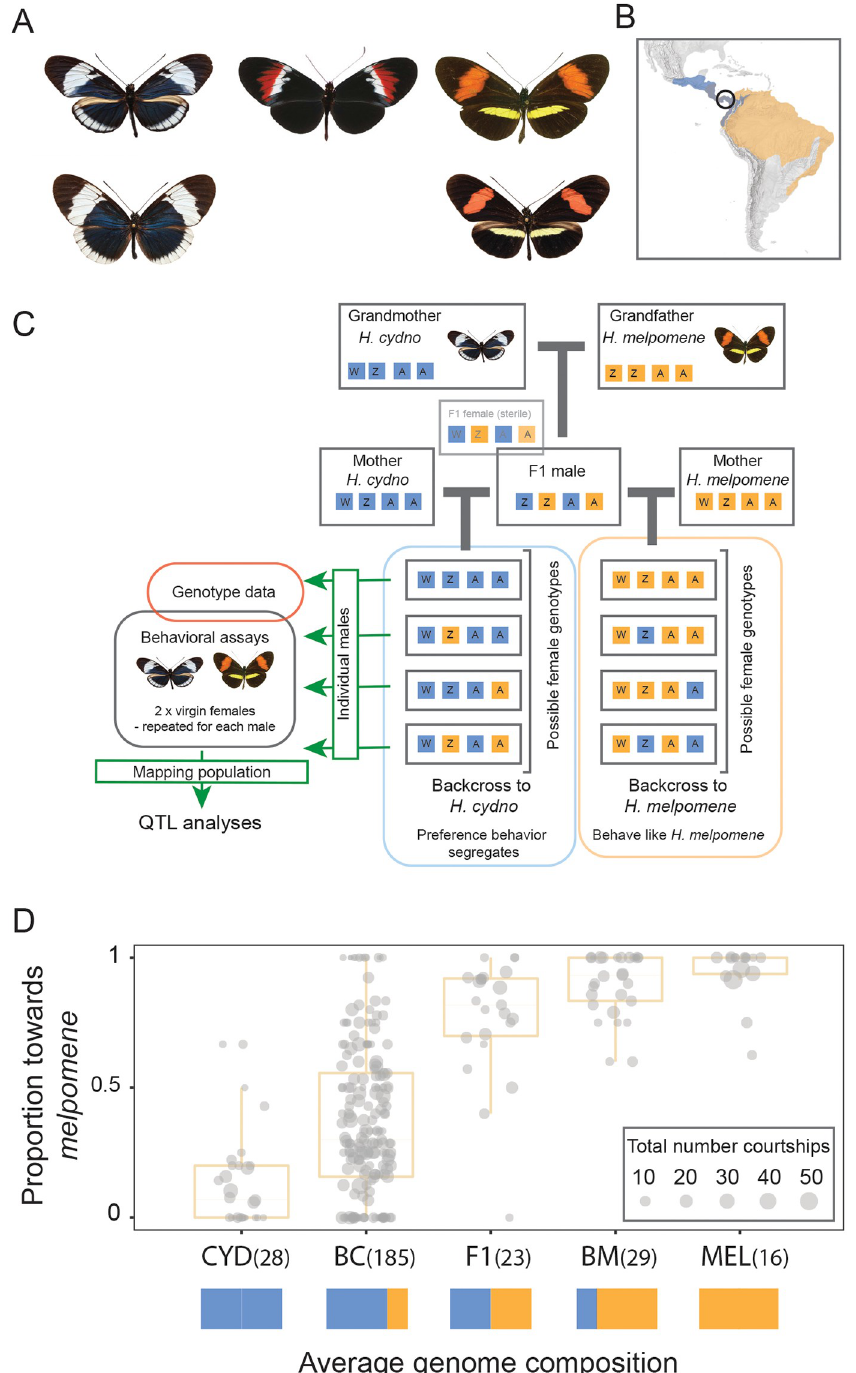
Fig 1. Divergence in warning pattern cue and corresponding preference in sympatric Heliconius butterflies. (A) Wing pattern phenotypes of top, H . cydno chioneus (left), H . melpomene rosina (right), their nonmimetic first- generation hybrid (center); and bottom, their sympatric comimics H . sapho sapho (left) and H . erato demophoon (right). (B) Distribution of H . cydno (blue) and H . melpomene (orange). Individuals were collected and experiments performed in Panama (black circle), where the two species co-occur in Central and northern South America. (C) Overview of crossing design. Colored boxes represent segregating H . cydno (blue) and H . melpomene (orange) alleles; Z and W refer to the alleles on the sex chromosomes and A to those on autosomes. (D) Proportion of courtships directed toward H . melpomene (as opposed to H . cydno ) females for CYD, MEL, their F1, and BC and BM. Values